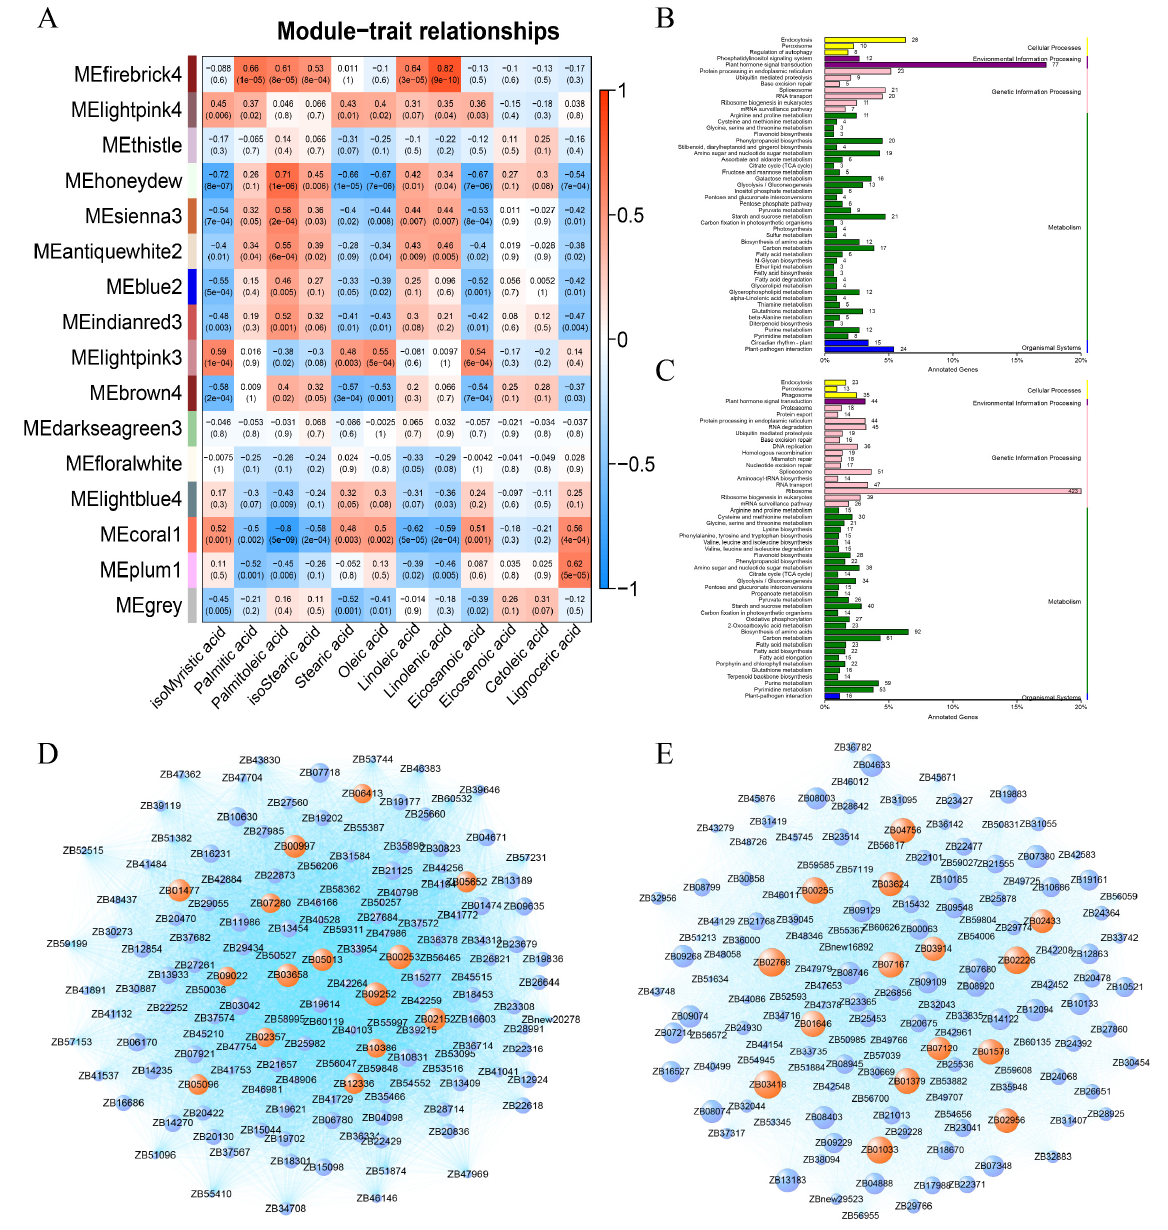
Figure 7. Weighted gene co-expression network analysis (WGCNA) for fatty acids in Z. bungeanum . ( A ) Correlations between modules and fatty acid composition traits; ( B ) KEGG annotation of genes in MEfirebrick4 module; ( C ) KEGG annotation of genes in MElightpink3 module; ( D ) Co-expression network of genes in MEfirebrick4 module; ( E ) Co-expression network of genes in MElightpink3